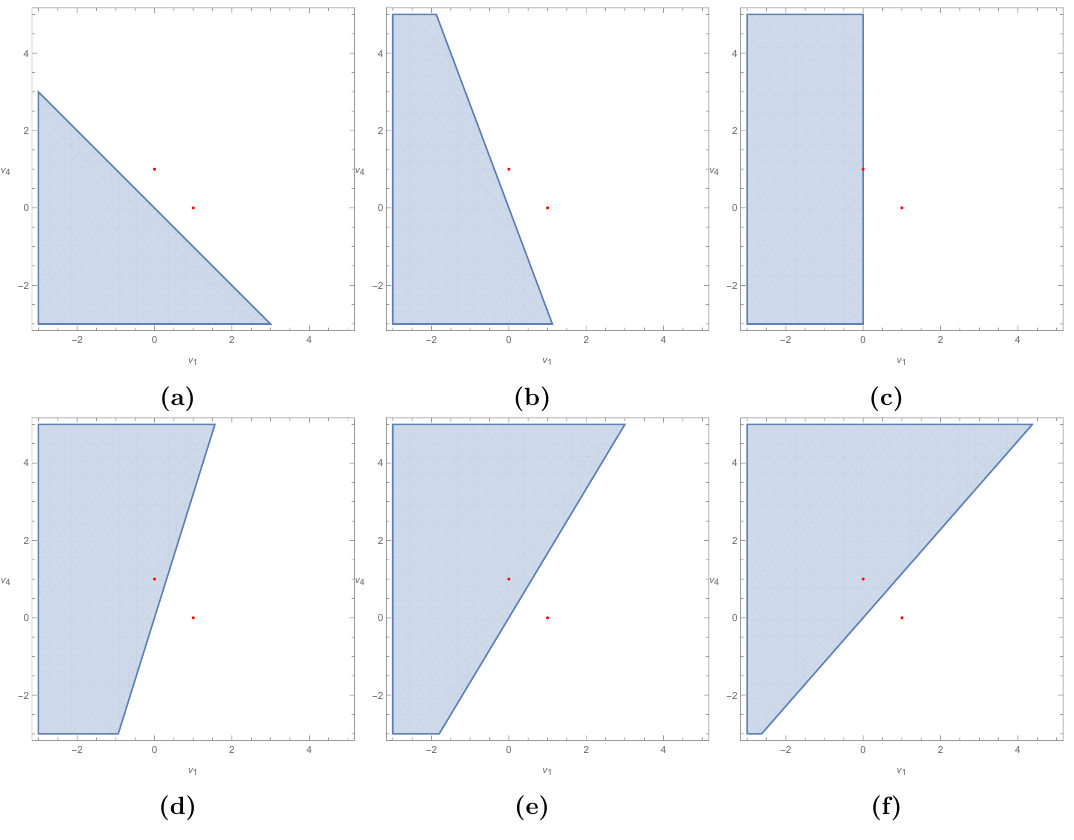
Figure 1. The region plot in v i -space for w 2 + x 2 + y 2 + z n +1 = 0 at n = 1 , . . . , 6 shown in (a) ∼ (f) respectively. The red points correspond to the two test symmetries and the blue area is the region where F < 0 in each picture. A red point inside the blue region indicates that the ring is